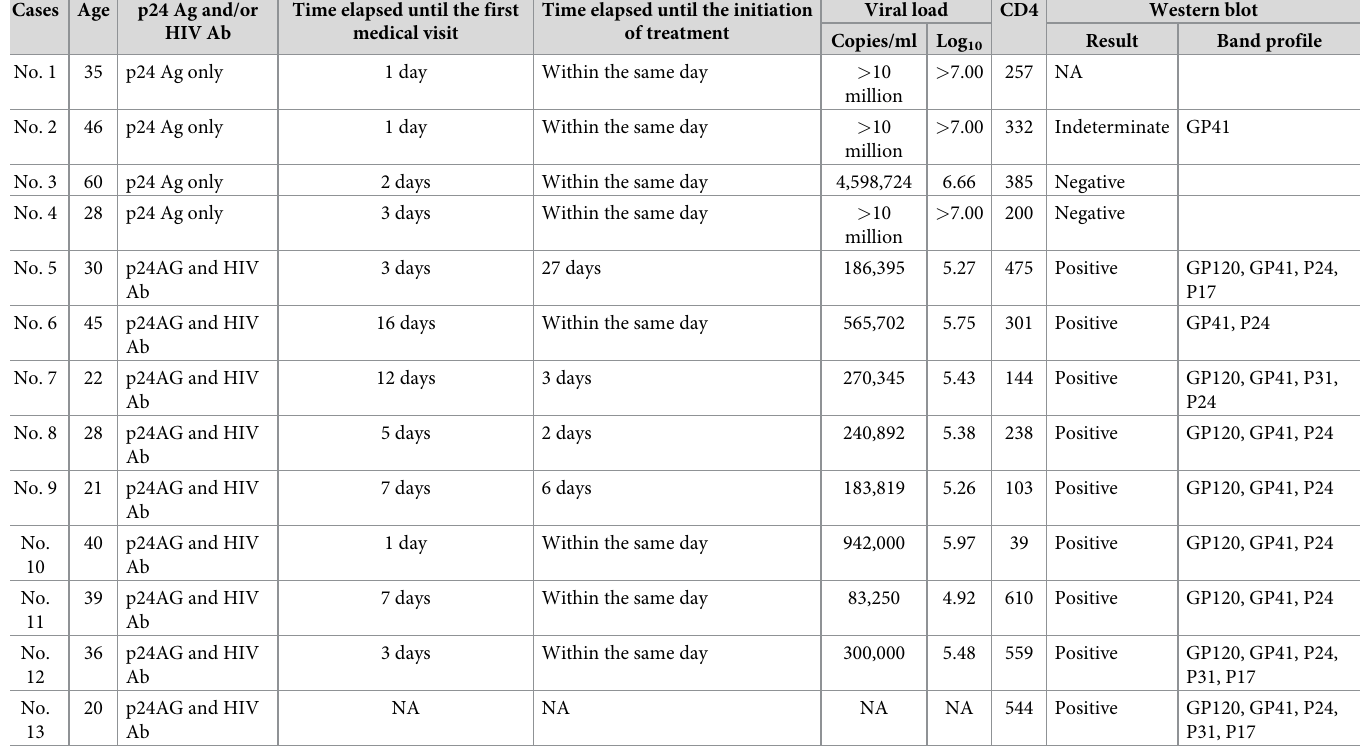
Table 3. Characteristics of HIV-positive users, including antigen and/or antibody positivity, viral load, time elapsed until access to treatment; BCN checkpoint, Spain (25 March 2016 to 24 March